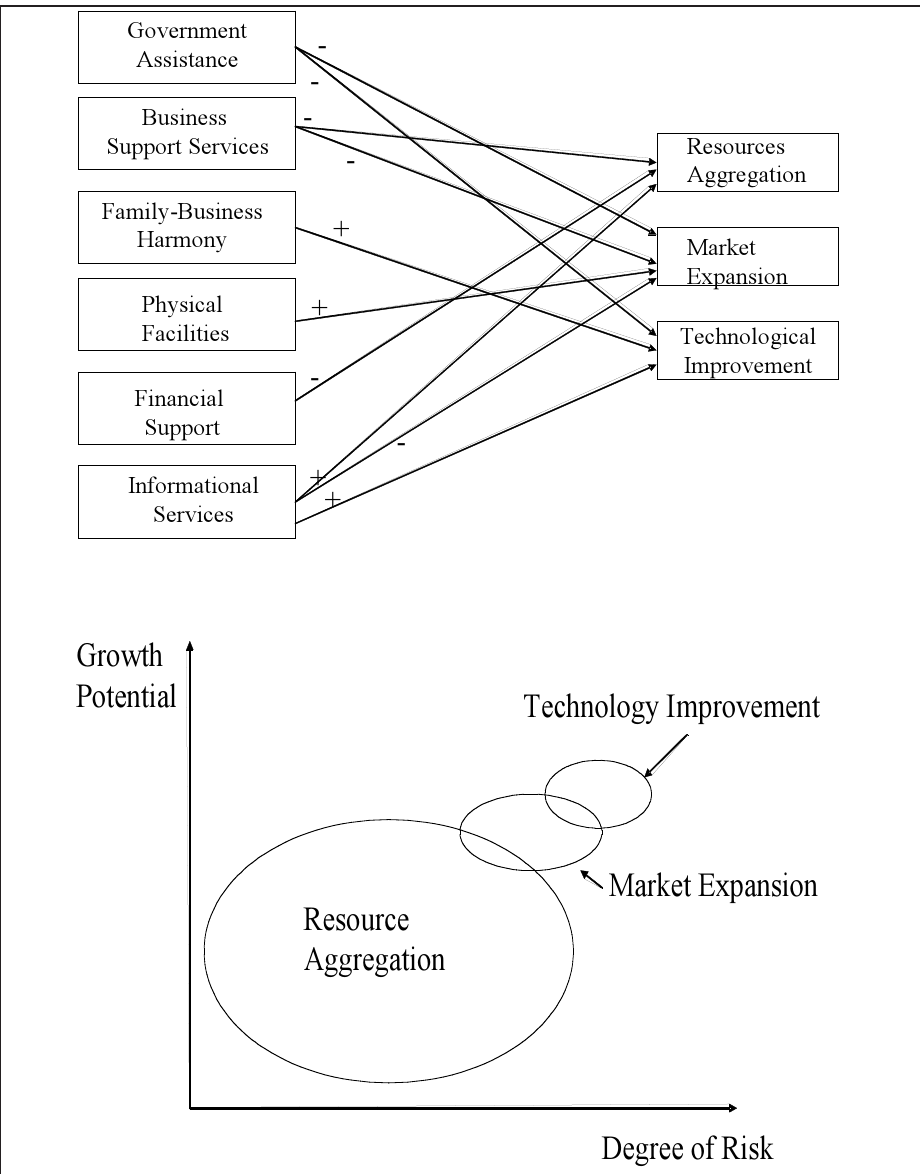
Figure 1. The Effect of Infrastructure on Entrepreneurial Expansion